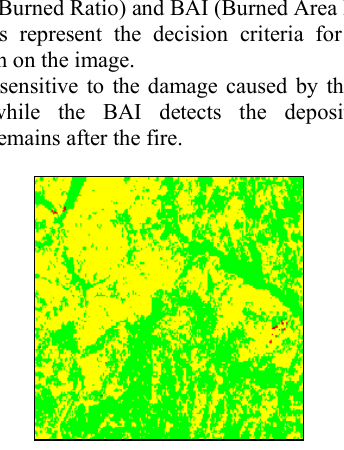
Figure 4. Discrimination of areas burned by the NBR in the decision tree